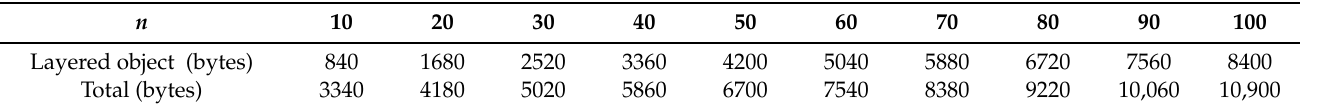
Table 1. Size of the layered object at the selected OM path lengths n . The row total gives the OM total size, including the payload of 2.5 kB.